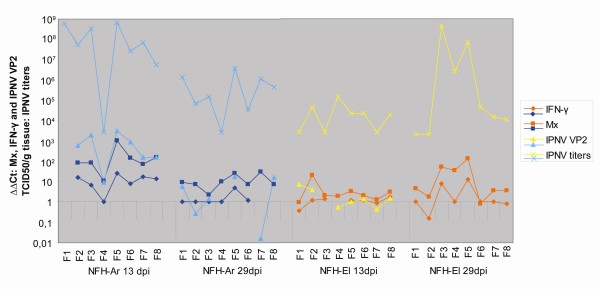
Variations in immune gene expression and virus levels between individuals. Transcript levels of Mx, IFN-γ and IPNV VP2 in head kidney and titers of IPNV in pancreas are shown at individual levels for the two IPNV isolates. The Mx and IFN-γ transcript levels are compared to uninfected control fish, while IPNV VP2 transcripts are compared to the NFH-El group 29d.p.i, IPNV titers were calculated by end point titration and results show TCID50/g tissue. For some individuals the transcript levels were undetected and are thus not presented.